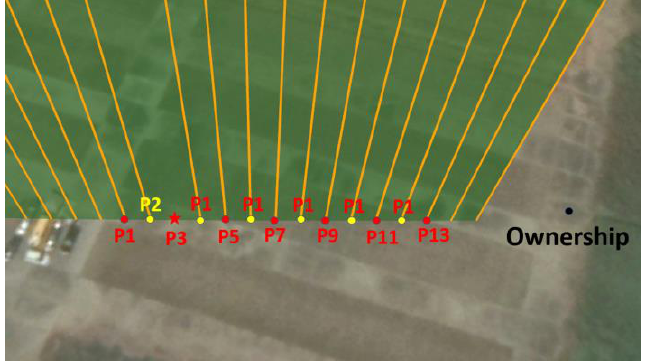
Figure 30. Measurements of GPS data for model evaluation in Experiment 4.